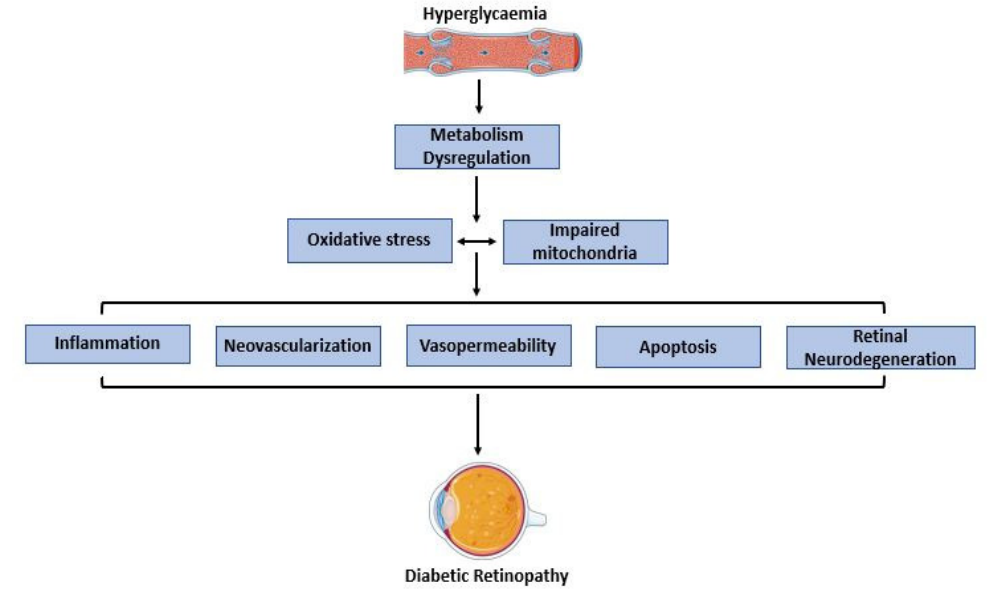
Figure 2. Overview of underlying mechanisms in diabetic retinopathy.